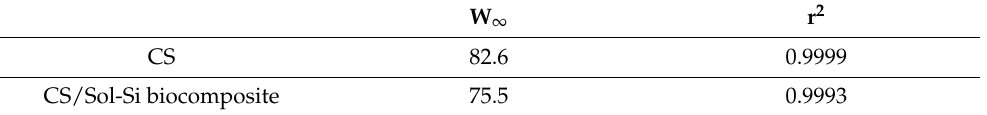
Figure 3. ( a ) Percentage of swelling of CS and CS/Sol-Si over a period of 24 h in PBS buffer. ( b ) CS and CS/Sol-Si experimental data for water content and time plotted according to a second-order kinetic model. Data were obtained from triplicate results and are shown as mean ± SD.